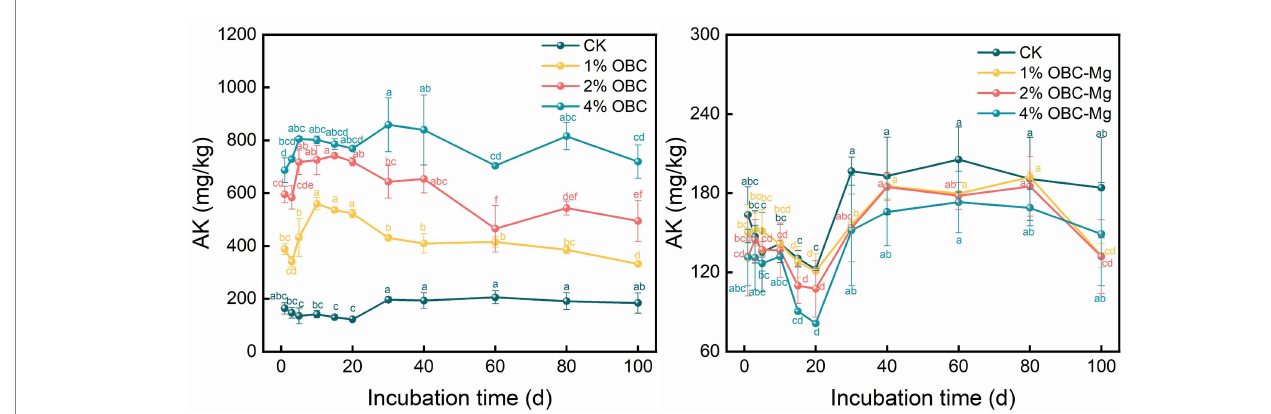
FIGURE 5 Changes in soil available potassium (AK) after the amendment of OBC and OBC-Mg.